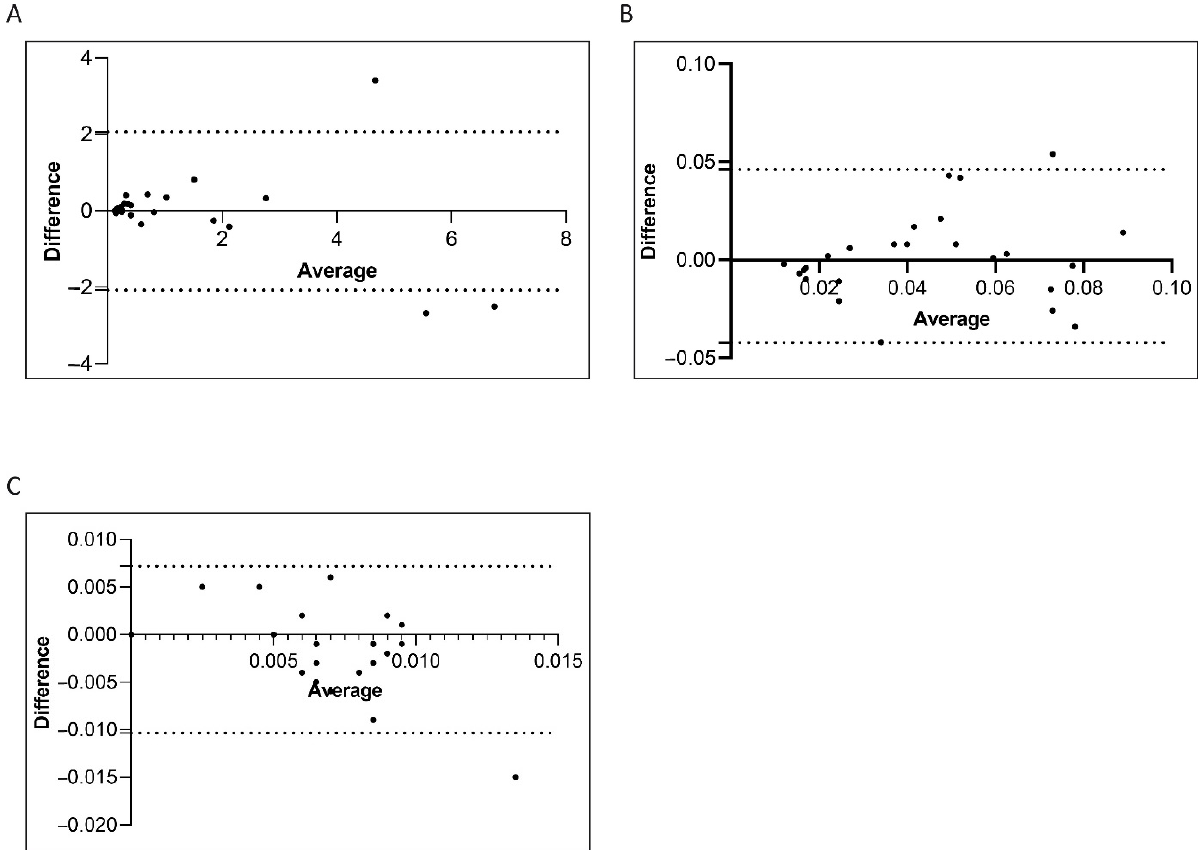
Figure 5. Bland–Altman showing the concordance of the BCR-ABL1/ABL1 IS transcript level measured by manual and semiautomatic methods . Paired measurements of BCR-ABL1/ABL1 IS were combined for patients stratified in four groups, each consisting of 25 subjects: Group A (10% > BCR-ABL1/ABL1 IS > 0.1%) ( A ), Group B (0.1% > BCR-ABL1/ABL1 IS > 0.01%) ( B ), Group C (0.01% > BCR-ABL1/ABL1 IS > 0.0032%) ( C ). The graph is plotted on the XY axis where X represents the difference of the two measurements, and the Y -axis shows the mean of the two measurements. Horizontal lines are drawn at the mean difference between the two methods and the upper and lower limits of agreement. The 95% confidence intervals are shown for the mean and the upper and lower limits of agreement.